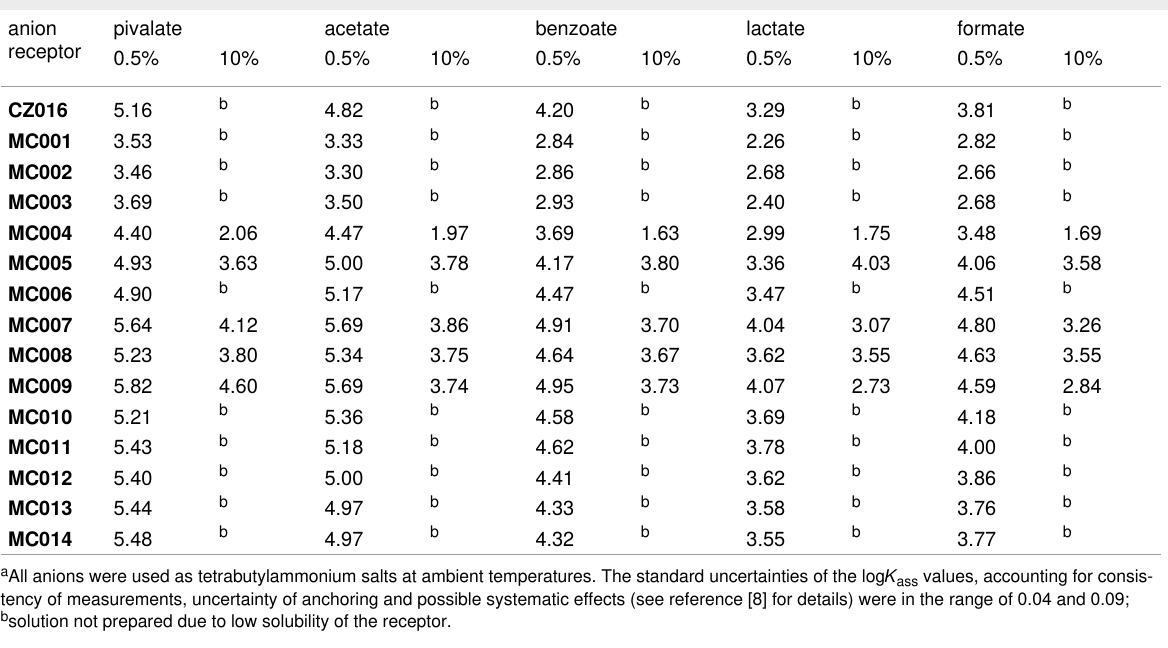
Table 1: Binding affinities log K ass of different carboxylates in 0.5% and 10% DMSO- d 6 /H 2 O solvent systems. a